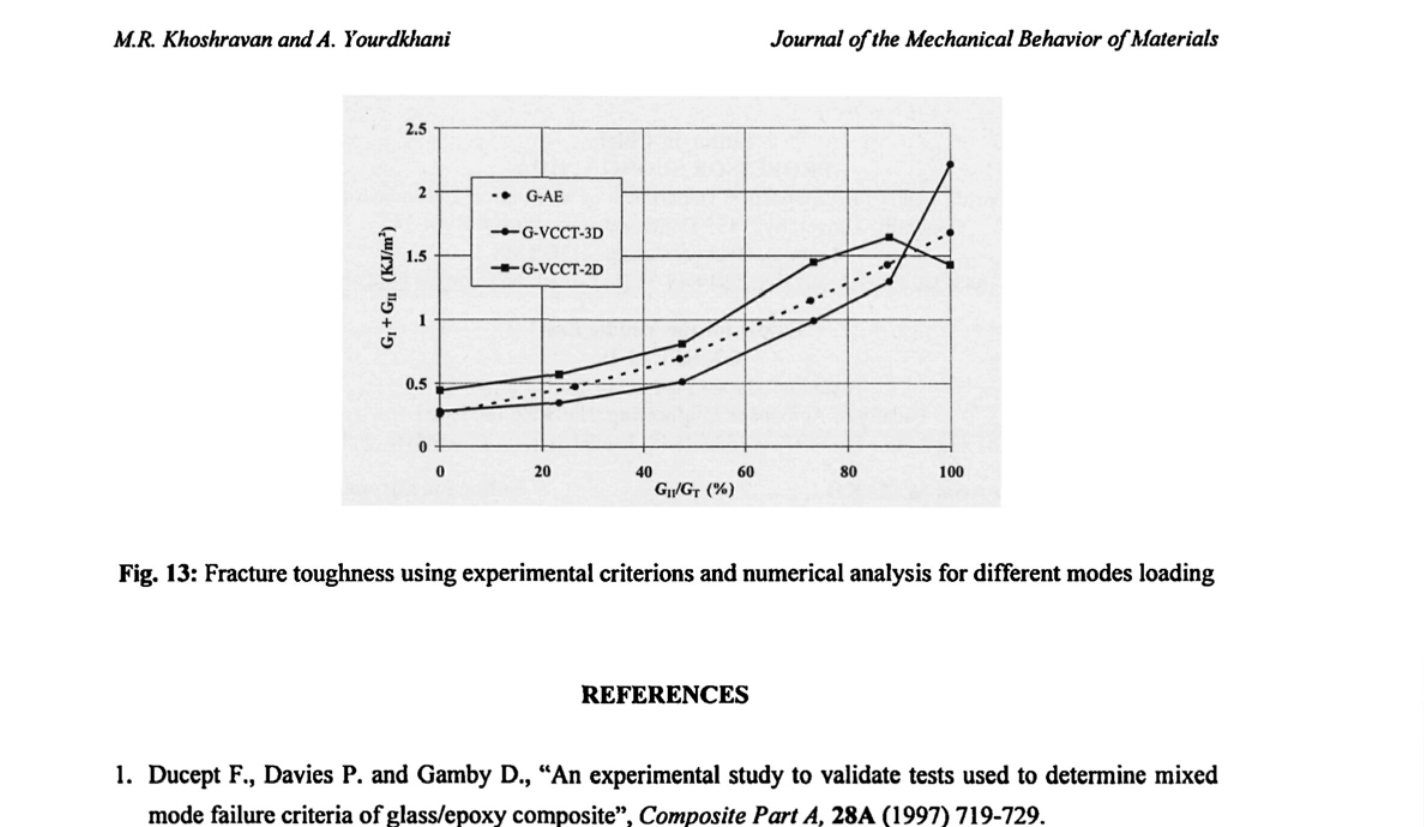
Fig. 13: Fracture toughness using experimental criterions and numerical analysis for different modes